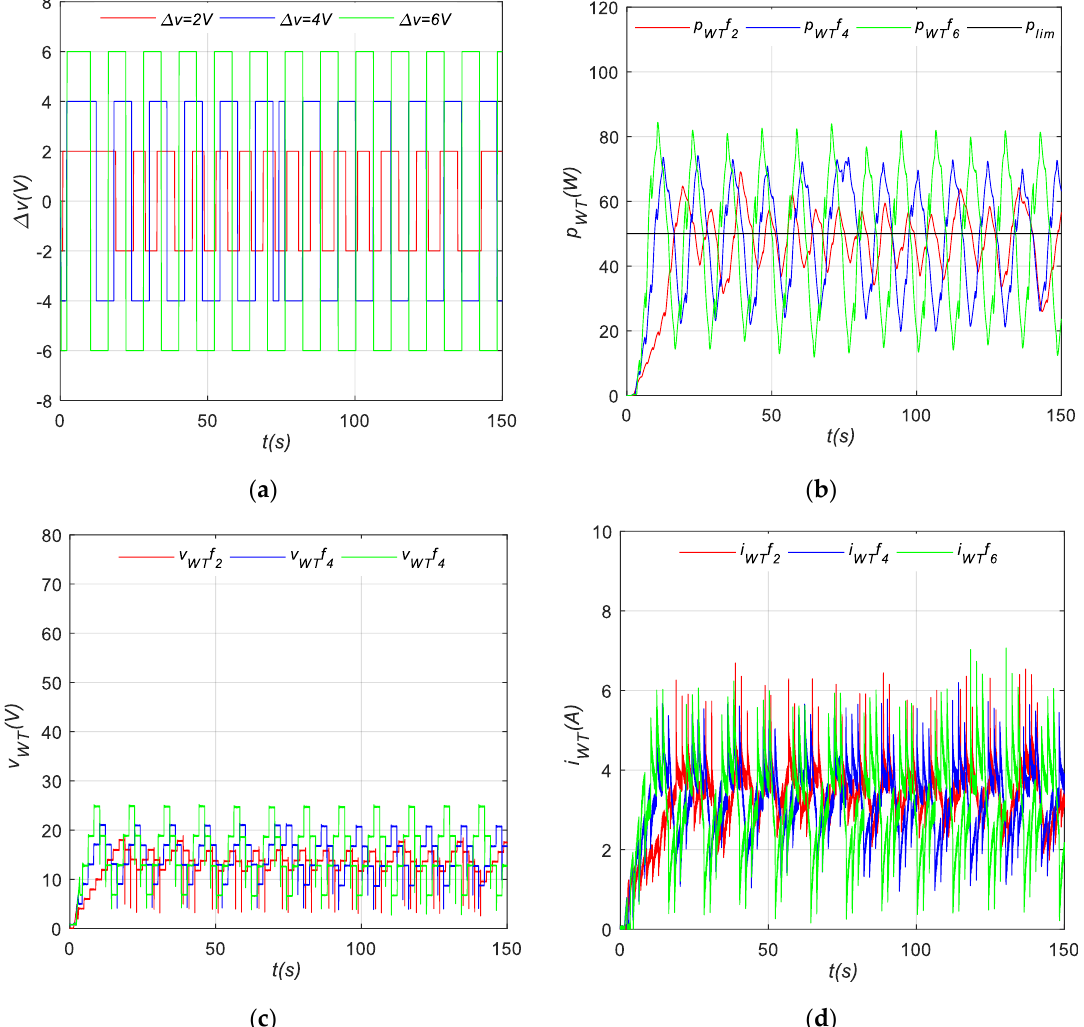
Figure 9. Fixed step-size P&O for LPP1: ( a ) evolution of step size Figure9. Fixedstep-sizeP&OforLPP1: ( a )evolutionofstepsize ∆ v ; ( b )evolutionof p WT ; ( c )evolutionof v WT ; ( d ) evolution of i WT